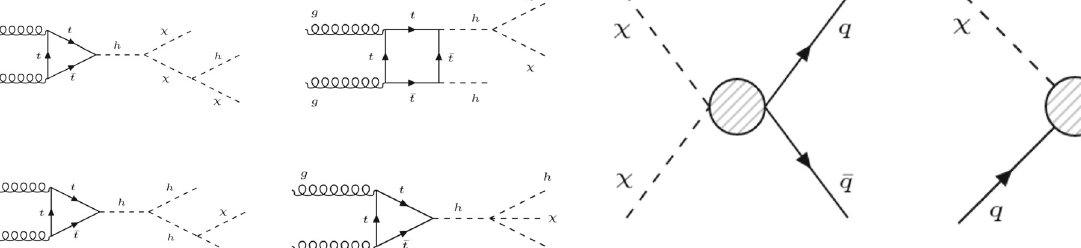
Fig. 3 Generic diagrams for annihilation of DM pair into SM states (left) and DM-nucleon elastic scattering (right) with contribu- tions from dimension-6 and -8 operators